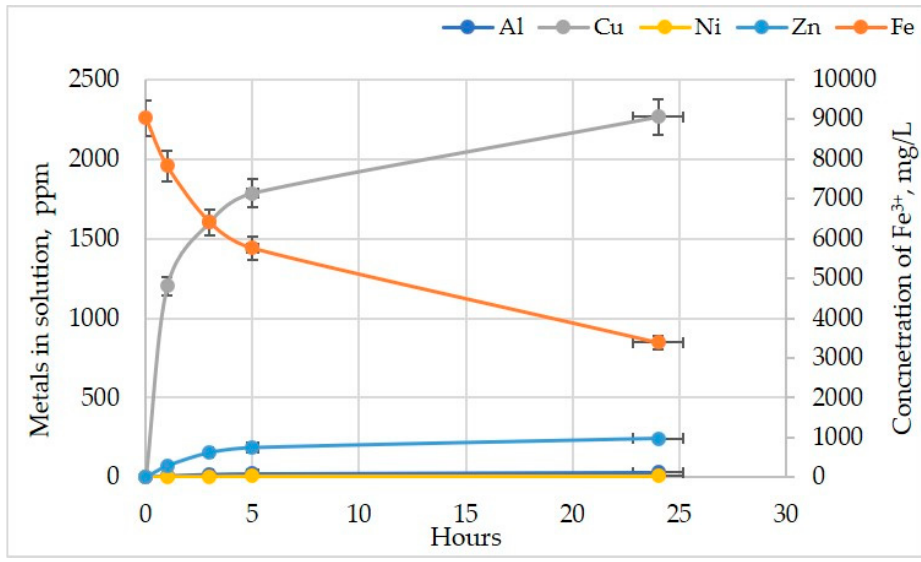
Figure 4. Evolution of metal ions and Fe 3+ in the PLS with time (40 °C; 1% PD; pH 1.0; initial concentration of Fe 3+ 9/L).